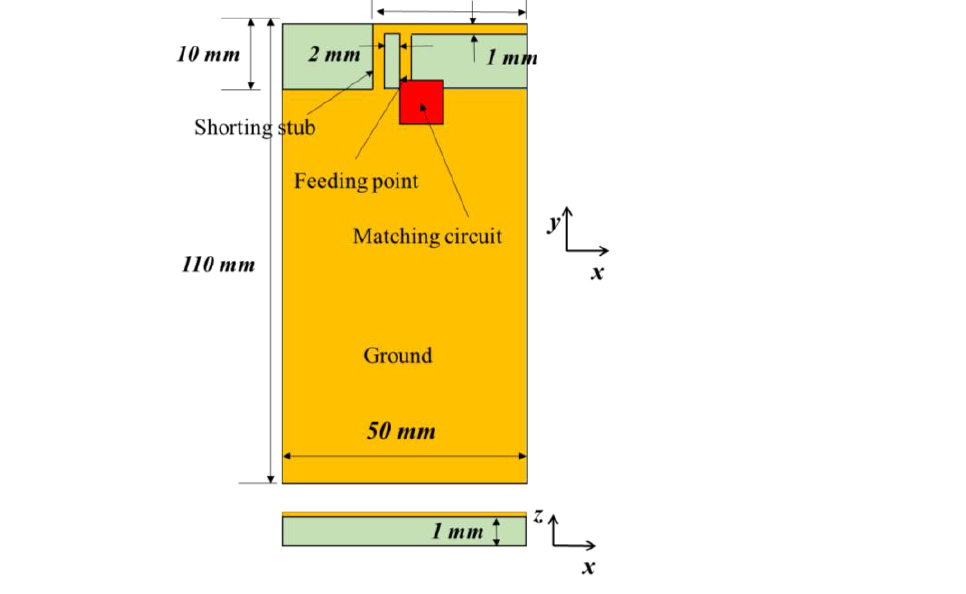
Figure 1. Antenna structure for impedance simulation.